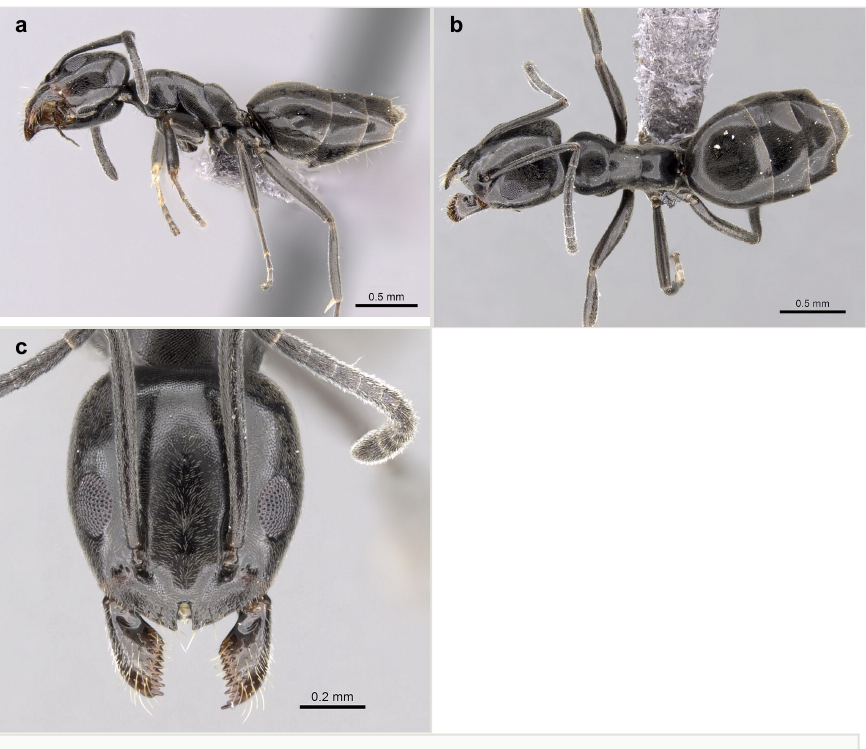
Figure 3. Tapinoma simrothi , CASENT0263927, Estella Ortega, AntWeb.org. a : body in